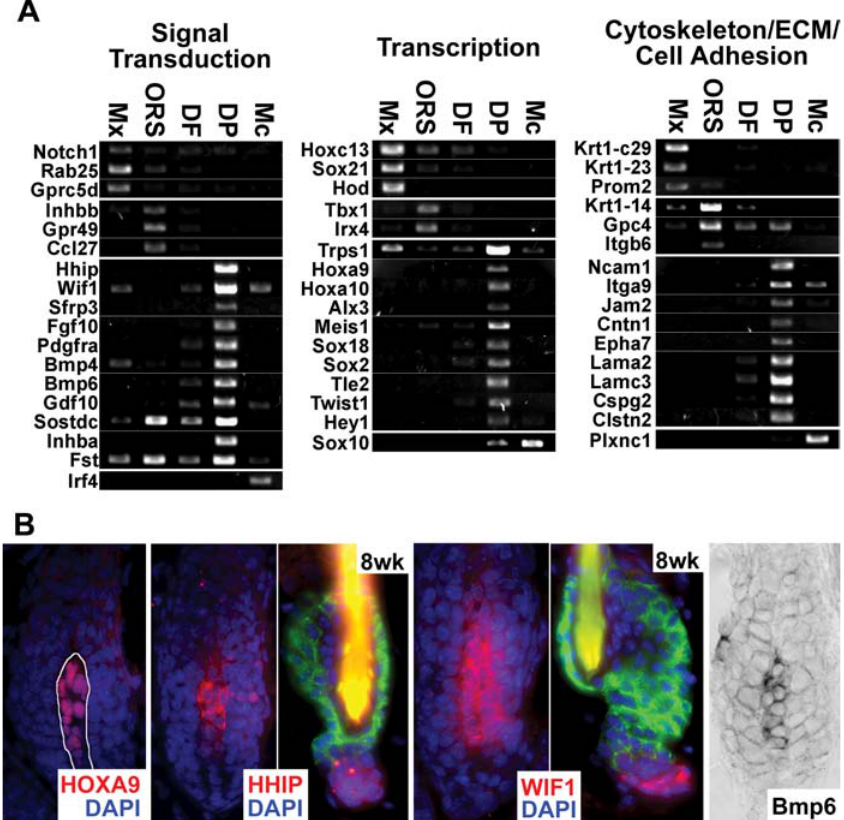
Figure 5. Implementation of Array Analyses to Examine Characteristics and Dynamics of the Follicle DP Niche (A) Semi-quantitative RT-PCR on mRNAs isolated from each population. Shown are representative data from molecular signature genes (see Figure 4) whose expression patterns in the DP niche environment had been previously uncharacterized. In this case, categories were consolidated into three groups: Signal transduction, transcription/nuclear, and cytoskeleton/ECM/cell adhesion. For each primer set, at least three different cycles were employed, and the resulting cDNA fragments were resolved by agarose gel electrophoresis along with DNA size markers to confirm that bands were of the expected sizes. For each gene, the data presented were from the cycle that provided the most meaningful comparisons. Note: bands seen in . 1 fraction accurately reflect mRNA expression at the differences in levels shown. (B) Immunohistochemistry and in situ hybridizations. Skin sections were taken from 2-mo-old K14-GFPactin mice [49] whose follicles were at the transition from the resting to growing (telogen to anagen) stage of the hair cycle (8 wk) or from P4 WT mice (full anagen follicles) (all others). Sections were subjected to either immunofluorescence using color-coded Abs as indicated or in situ hybridization using the indicated biotinylated cRNA probes (sense controls were negative). DOI: